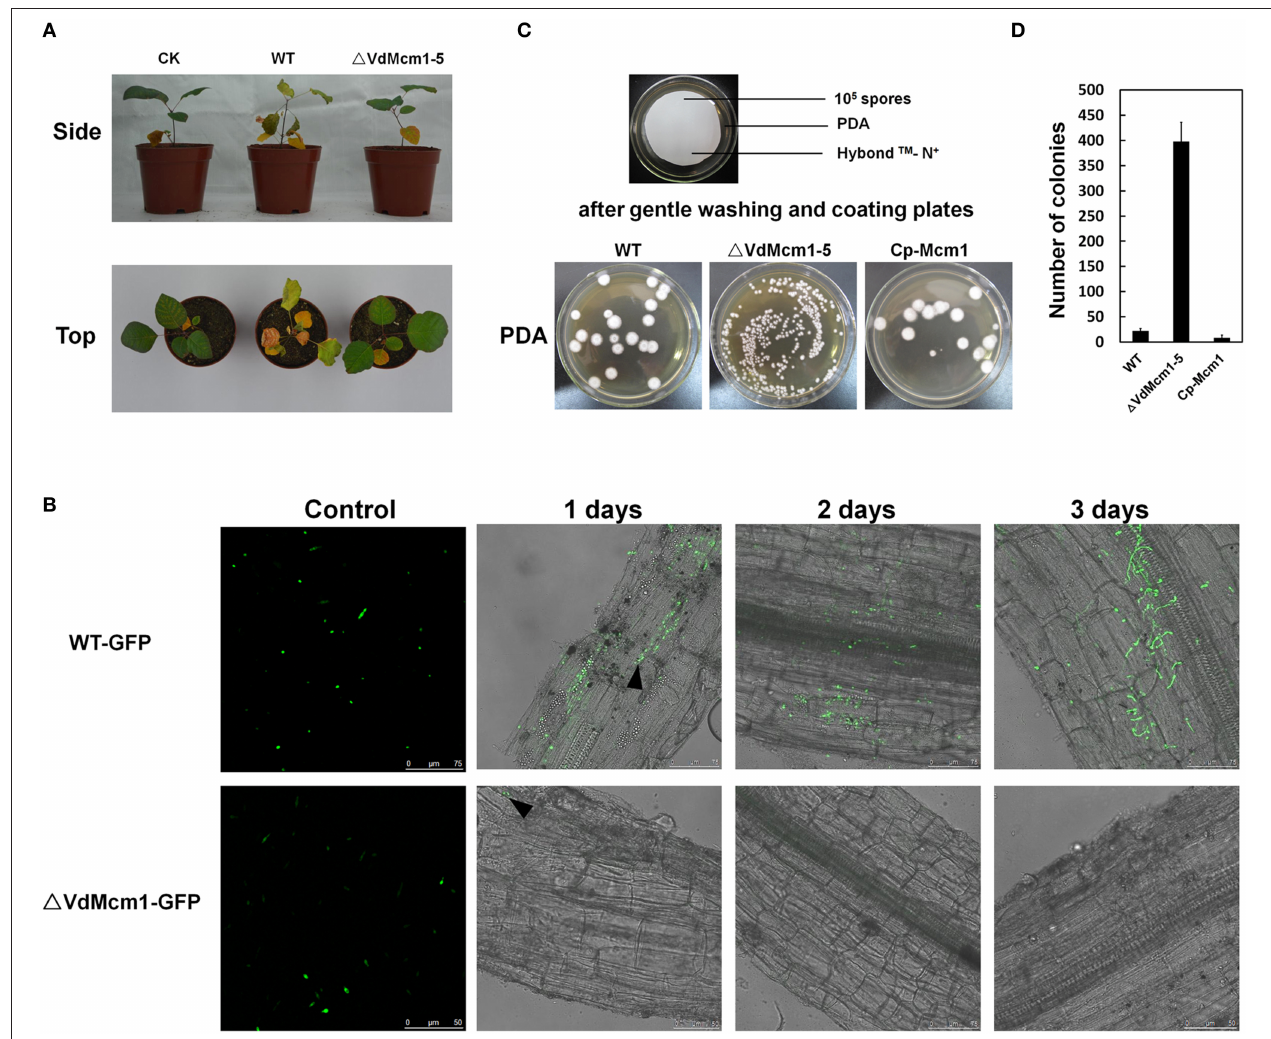
FIGURE 7 | Pathogenicity assays of VdMcm1 deletion mutants on smoke trees and tobacco seedlings. (A) Side and top views of one-year-old smoke tree seedlings inoculated with 10 6 spores/ml conidial suspension of the wild-type and 1 VdMcm1-5 for 10 min. The smoke tree seedlings in CK were inoculated with distilled water for 10 min. The pictures were taken at 30 days after inoculation. (B) Microscope observation of 1-month-old tobacco roots inoculated with GFP-expressing wild-type strain (WT-GFP) and 1 VdMcm1-5 ( 1 VdMcm1-GFP ), respectively. 10 6 conidia/ml of WT-GFP, 1 VdMcm1-GFP were used. The arrowheads indicated adherent conidia on the root epidermis. The scale bars represent 75 µ m. (C) Conidial adhesion tests. 10 5 conidia harvested from liquid CM were grown on Hybond TM -N + membranes that were overlaid on PDA plates for 18 h. 1 ml distilled water was used to gently wash through the membranes and repeated five times, and about 750 µ l conidial suspensions were acquired. Fifty microliter conidial suspensions were spread over the PDA plates. The pictures were taken after 5 days of growth. (D) The number of colonies grown on PDA plates after 5 days. The error bars represent standard deviations. The experiments were performed in